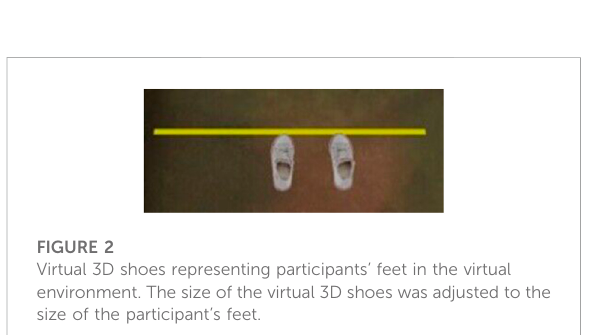
FIGURE 2 Virtual 3D shoes representing participants ’ feet in the virtual environment. The size of the virtual 3D shoes was adjusted to the size of the participant ’ s